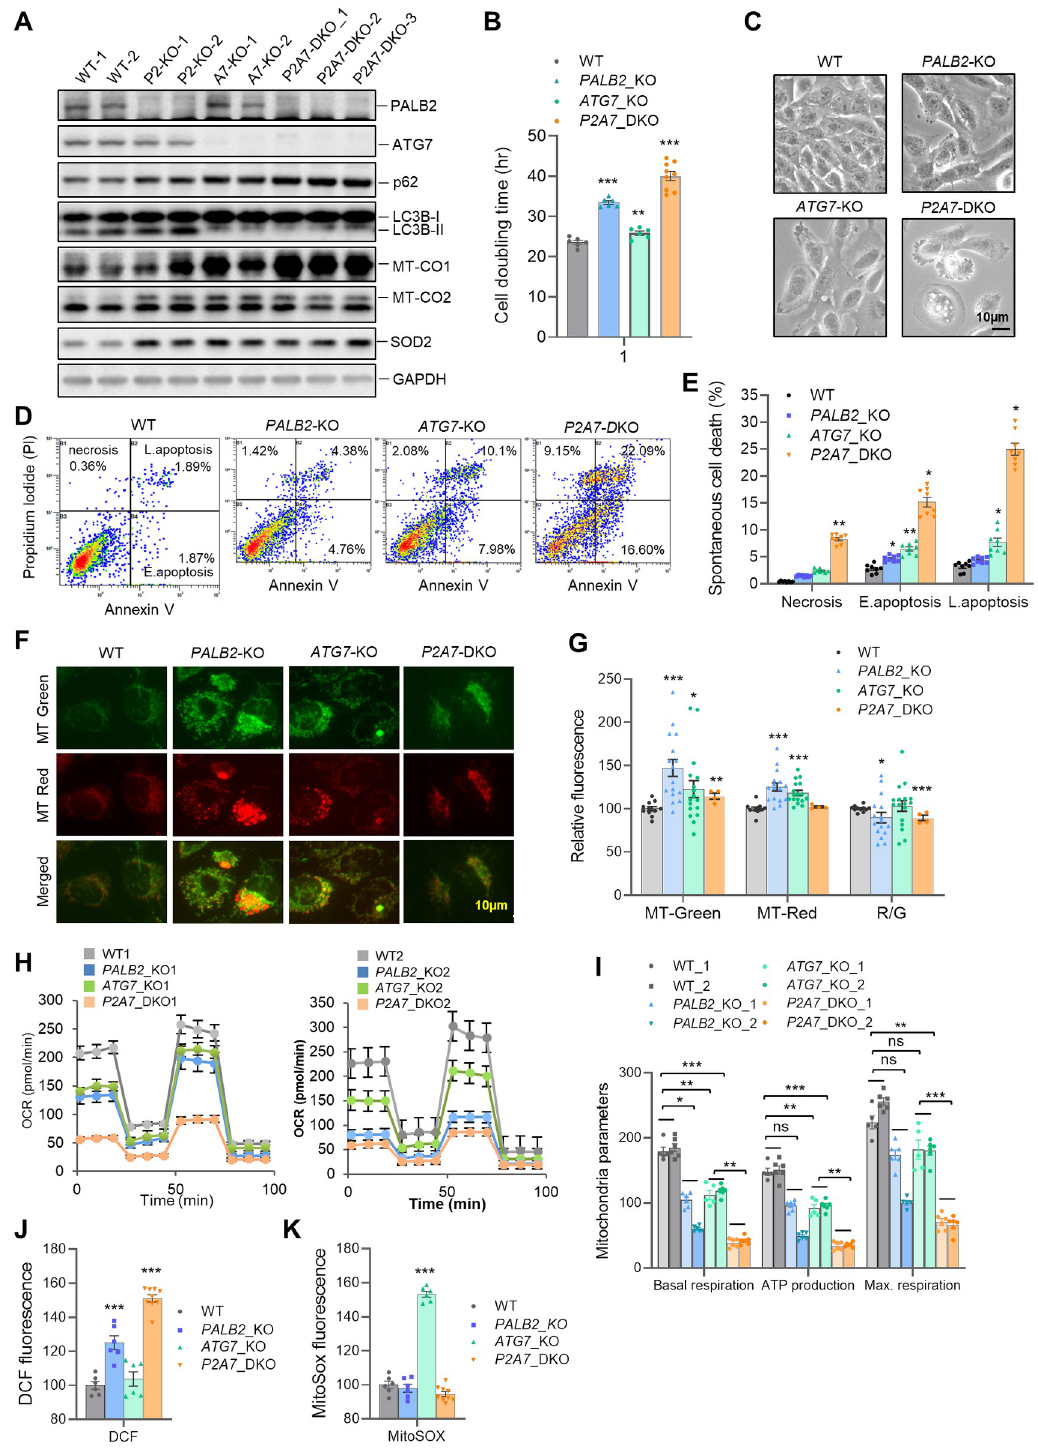
Fig 5. Mitochondrial abnormality, oxidative stress, and apoptosis in PALB2 and ATG7 KO human medulloblastoma cells. (A) Western blot analysis of whole cell homogenates of WT and KO cells. All 9 cell lines were from single clones. The WT cell lines were false positive clones from the PALB2 CRISPR/Cas9 KO procedure. (B) Doubling times of WT and KO cells of the 9 cell lines in A. n = 3 independent experiments. Cells of the same genotype were grouped together. (C) Representative bright field microscopy images of the cells. Scale bar = 10 μ m. (D and E) Representative flow cytometry plots (D) and quantification (E) of